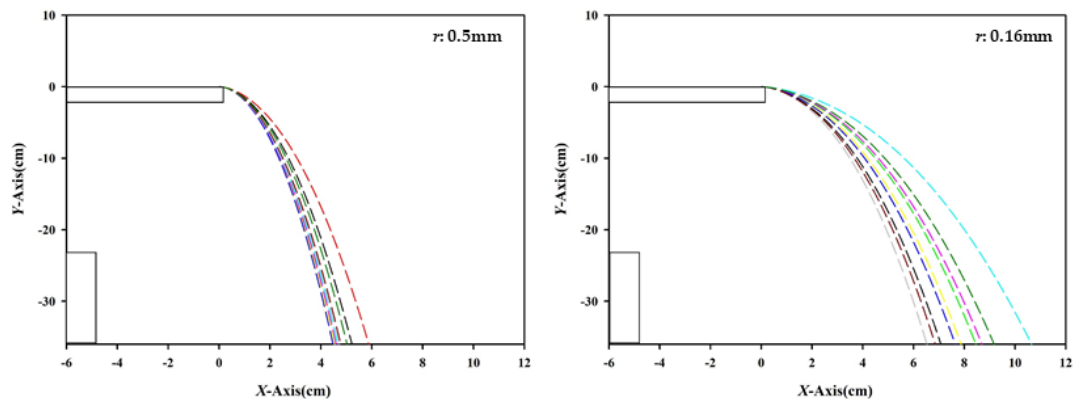
Figure 13. Observed trajectories of various large and small pretreated glass particles (applied voltage: 20 kV, relative humidity: 35%, distance between electrodes: 60 cm, initial speed: 0.13 m/s).